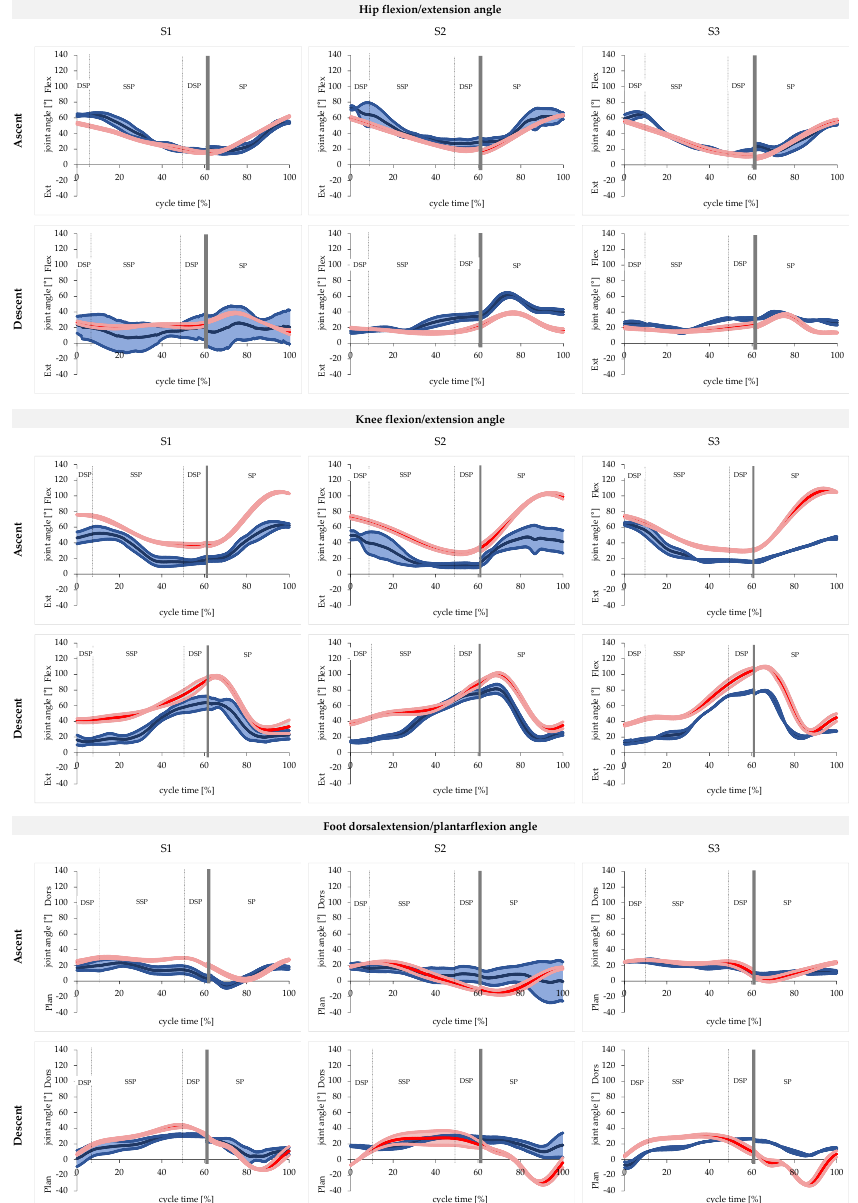
Figure 6. Foot, knee, and hip angle curves in the sagittal plane for ascent and descent without (red) and with (blue) the exoskeleton for Subject 1 ( left ), Subject 2 ( middle ), and Subject 3 ( right ); DSP = double stance phase, SSP = single stance phase, SP = swing